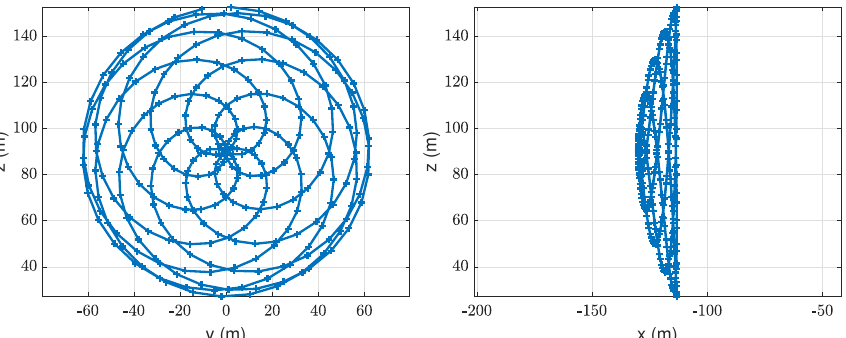
Figure 2. The rosette scanning pattern of the SpinnerLidar shown from two perpendicular